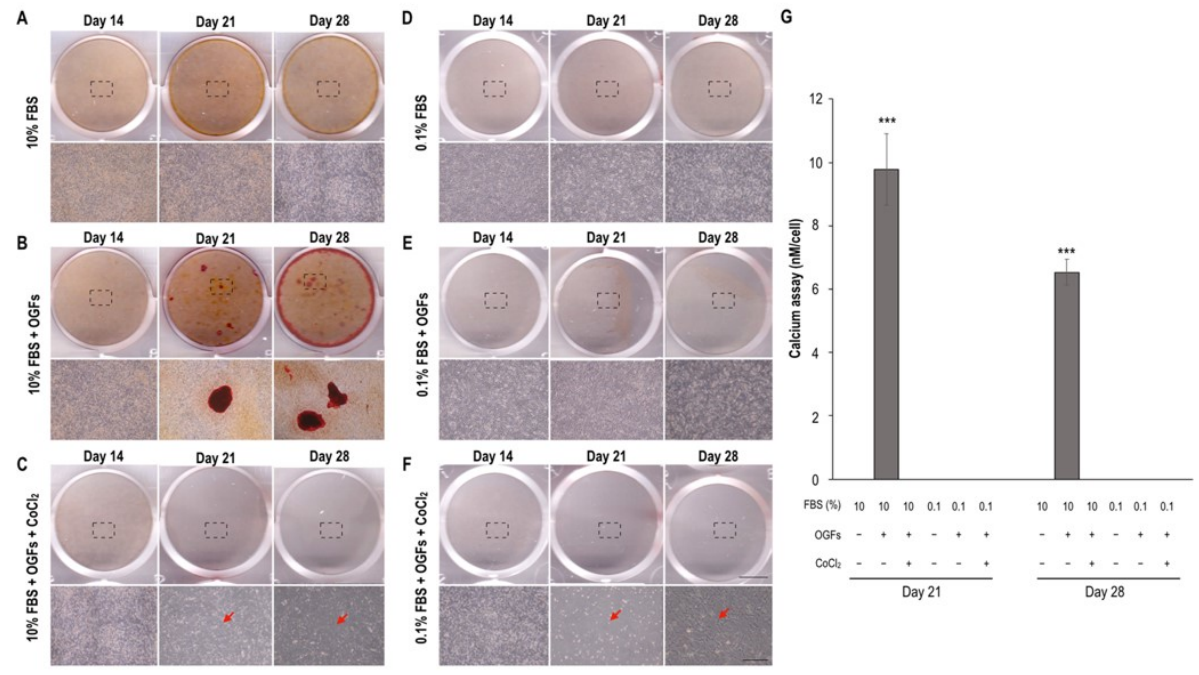
Figure 4. Calcification of OGF-induced MC3T3-E1 cells subjected to the stress of serum insufficiency with or without hypoxia. Red indicates calcification detected through Alizarin Red staining. Calcification was detected on Days 14, 21, and 28 after the administration of appropriate treatments. Images of 12-well dishes were captured with a scanner, and cell images are magnifications of the dashed box region. ( A ) Incubation with 10% FBS alone (normal control) did not trigger calcification until Day 28. ( B ) OGF-induced cells (positive control). Red nodules on the wells indicate calcification. ( C ) Effect of hypoxia on the calcification of OGF-induced cells. Arrows indicate neuron-like cells. ( D ) Effect of serum deprivation on pre-osteoblasts. ( E ) Coincubation with OGFs and 0.1% FBS. ( F ) Effect of ischemia on calcification. ( G ) Calcification assay. The O.D. value of the calcium concentration in each group was normalized to the total cell number. Each bar corresponds to a single group and represents the mean ± SD ( n = 3). Asterisks indicate significant differences (*** p < 0.001). Abbreviations: Ctrl, control; FBS, fetal bovine serum; OGFs, osteogenic growth